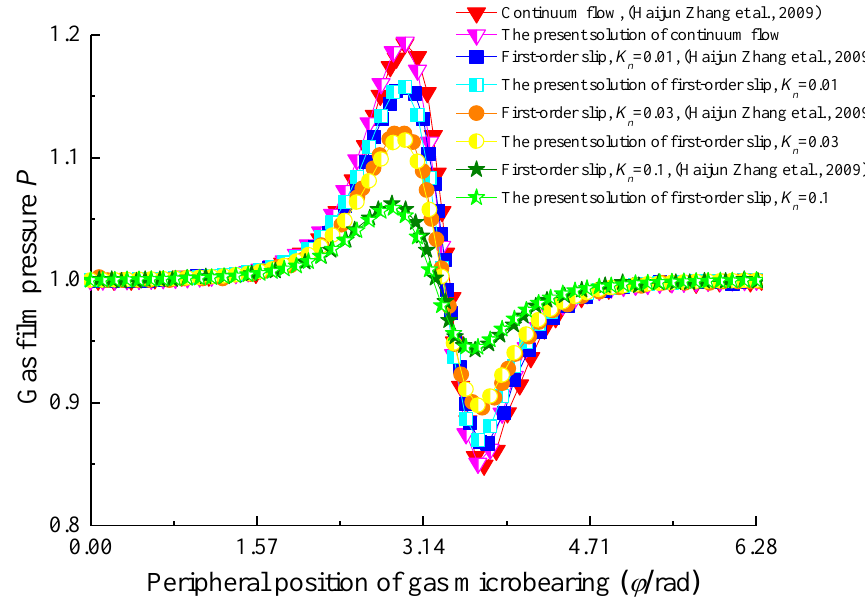
Figure 2. Comparisons of dimensionless gas film pressure distributions with Zhang et al. for different Knudsen numbers.